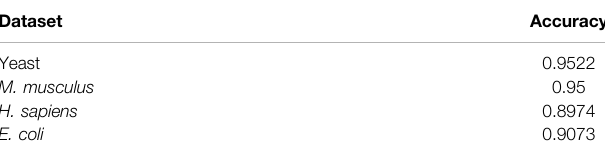
TABLE 6 | Performance (accuracy) of InferSentPPI on different independent